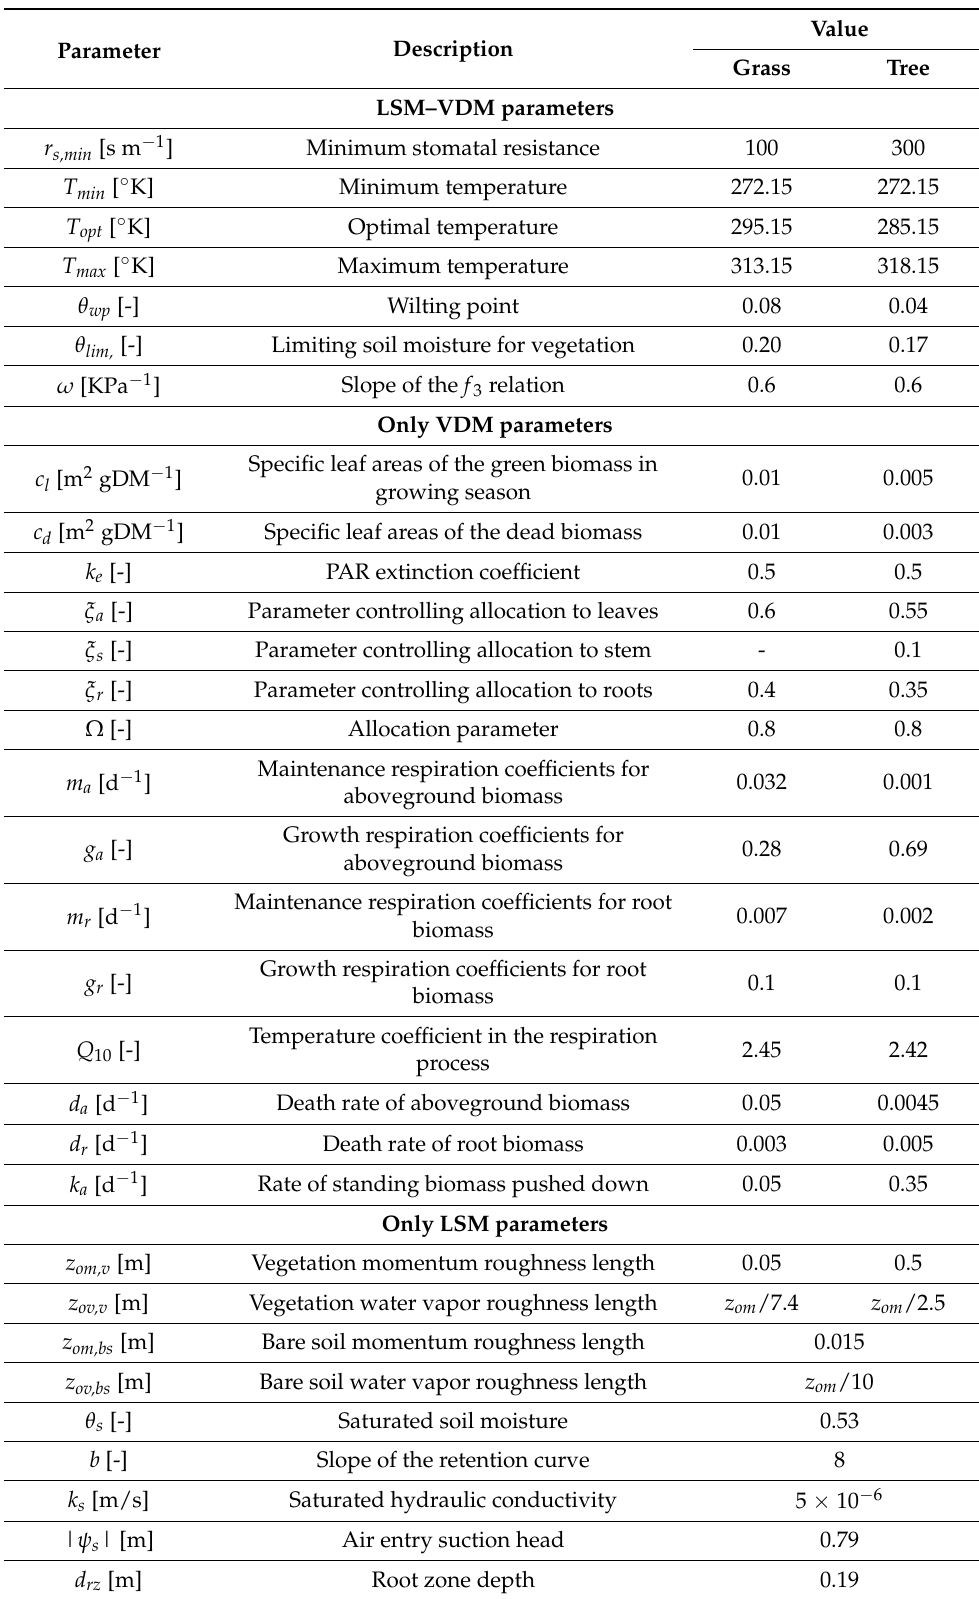
Table 3. Model parameters of the coupled LSM–VDM and their values for the Orroli site.